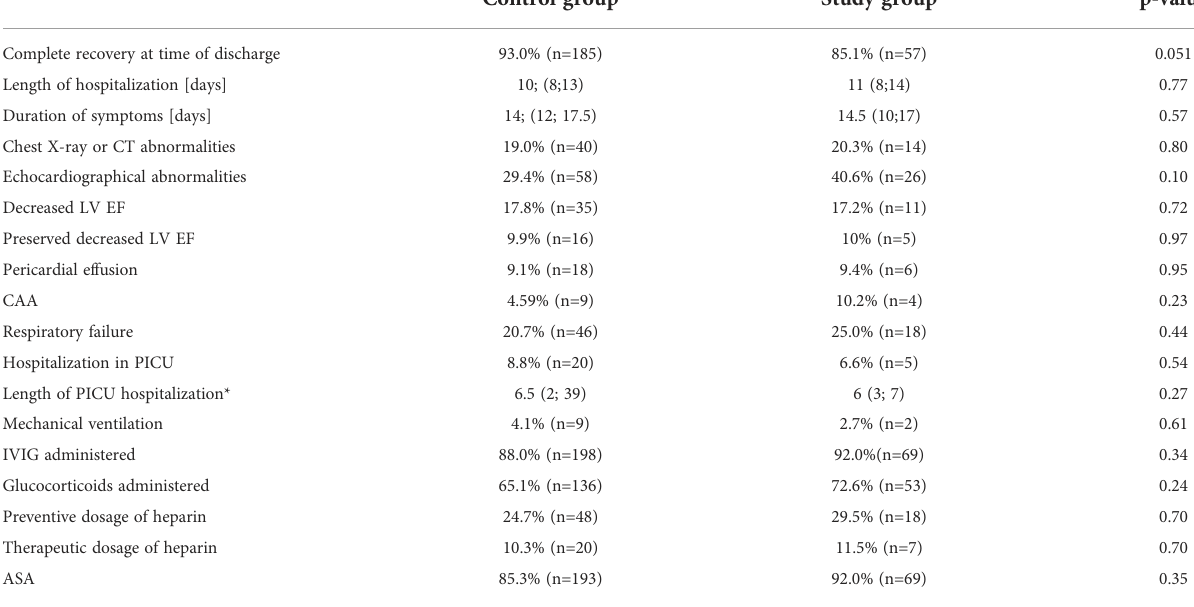
TABLE 6 Clinical fi ndings of control and study groups.